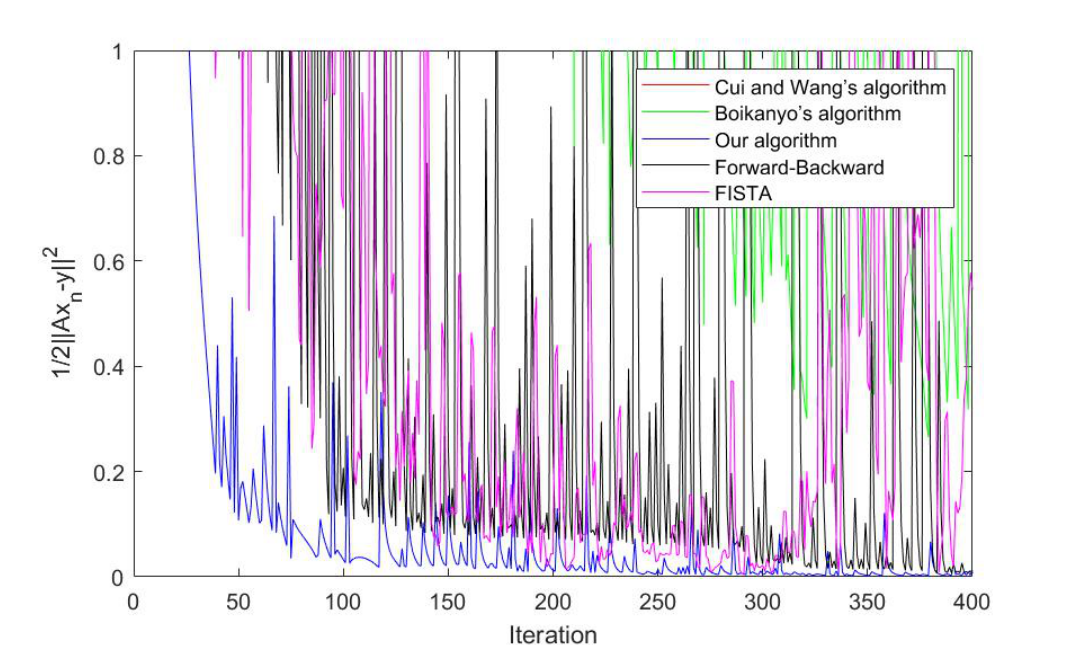
Figure 4. Case N = t = 100 and k =